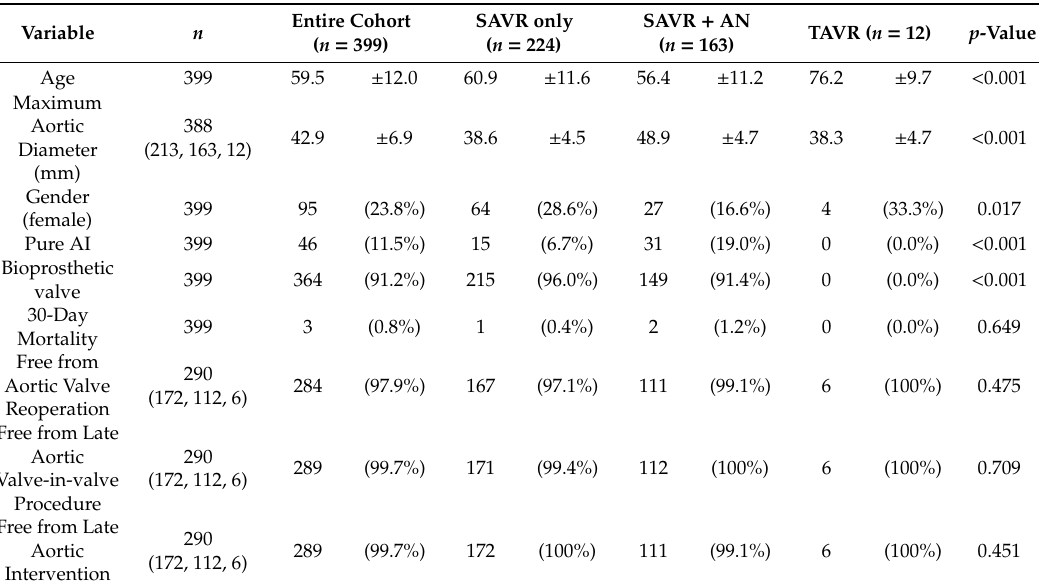
Table 2. Characteristics of surgery group by procedure.